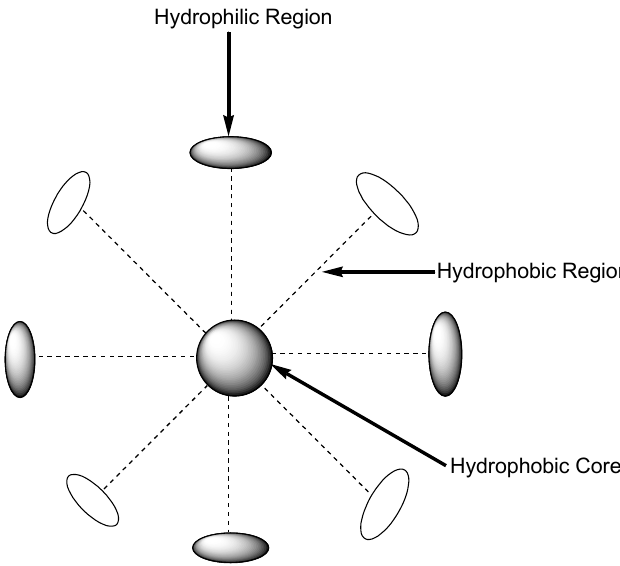
Figure 3. Schematic diagram of micelles.